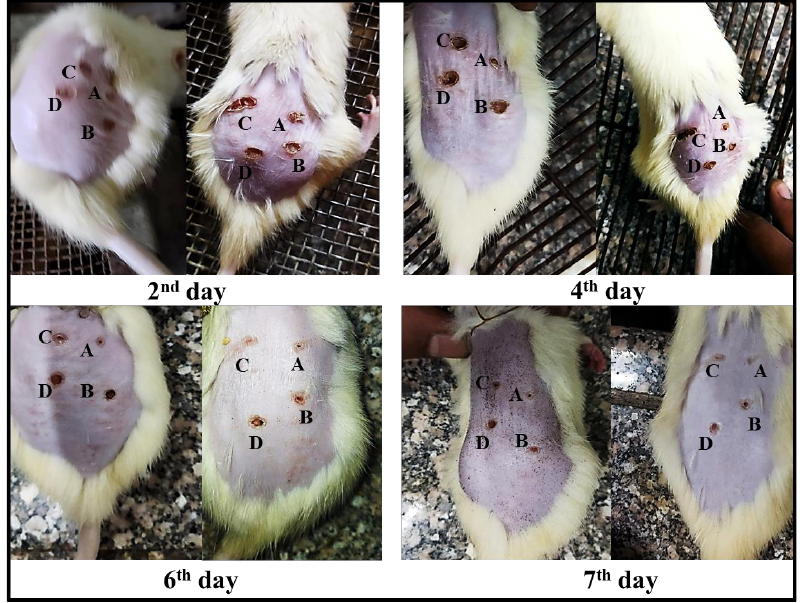
Figure 6. Burn healing process of two representative rats at different time intervals. Treatment was performed with the TTO-loaded nanolipogel (area A), the unmedicated nanolipogel (area B), TTO-loaded conventional gel (area C), and normal saline (area D).